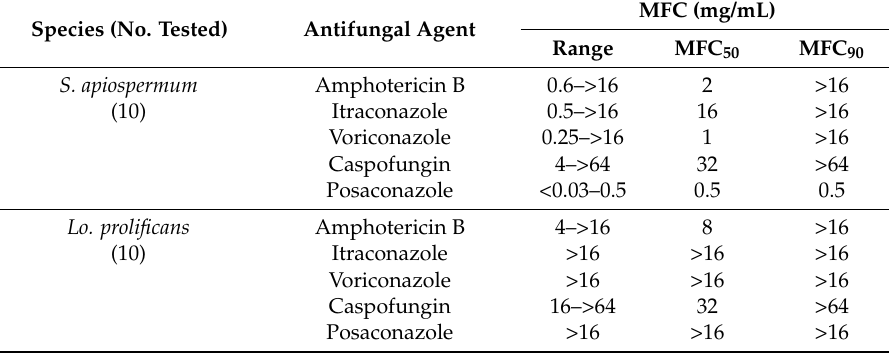
Table 6. Minimum fungicidal concentration (MFC) data for mould isolates. Fungicidal activities are highlighted in grey (i.e., fungicidal effect observed at or below ECV MIC for A. fumigatus with that antifungal agent). na—Not appropriate due to the small number of isolates tested for the species. nd—Not done. * Fusarium spp. included F. proliferatum (6), F. verticillioides (3), and F. oxysporum (4) species